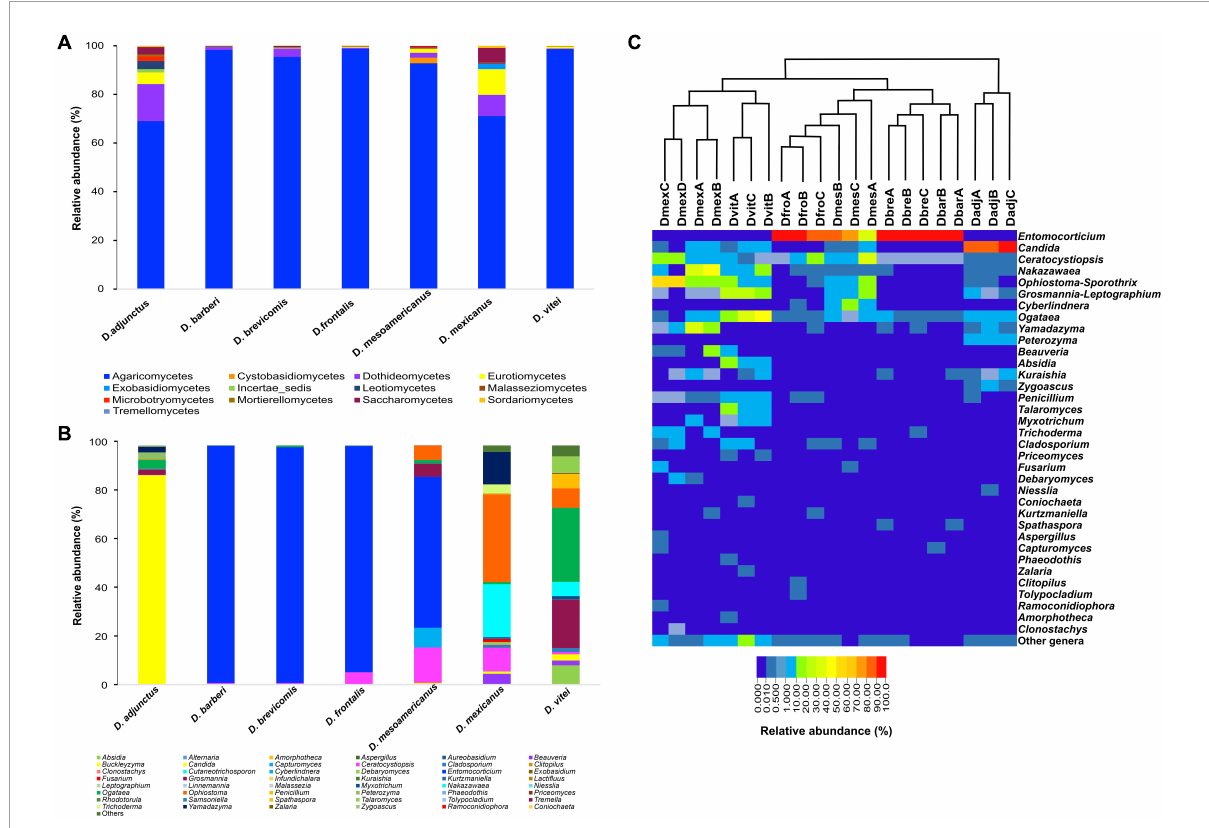
FIGURE1 Fungal diversity and relative abundance of mycetangial fungi from the species of the D . frontalis complex. Biological replicates of each beetle species were grouped in (A,B) , but not in (C) . (A) Bar diagram illustrating mycetangial fungi at the class level. (B) Bar diagram showing mycetangial fungi at the genus level. (C) Heat map showing mycetangial fungi per library at the genus level by beetle species, the 21 libraries were grouped by the unweighted pair group method with arithmetic mean (UPGMA) using the Bray-Curtis dissimilarity matrix; red color represent high abundance and strong blue low abundance.